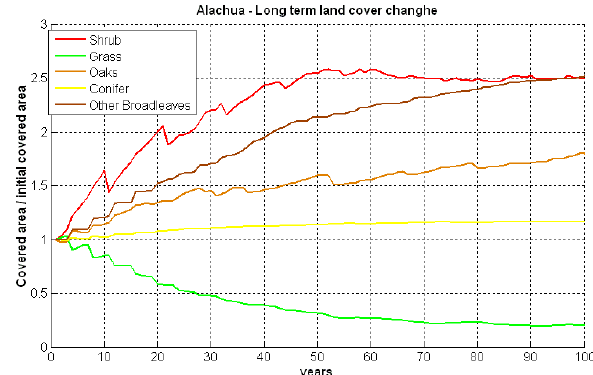
Figure 4. Long term simulation obtained using the vegetation succession model for Alachua Fig. 4. Long term simulation obtained using the vegetation succes- County case study. sion model for Alachua County case